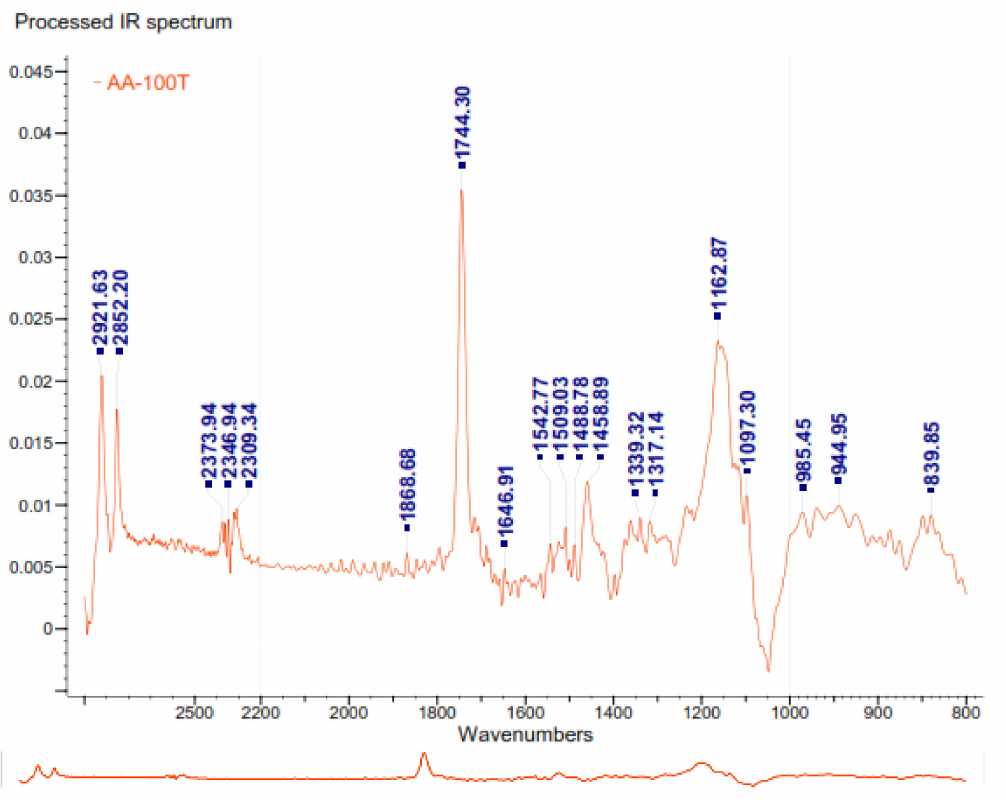
Figure A1. FTIR of sample AA-100T. Table A1. Analysis of FTIR results for sample